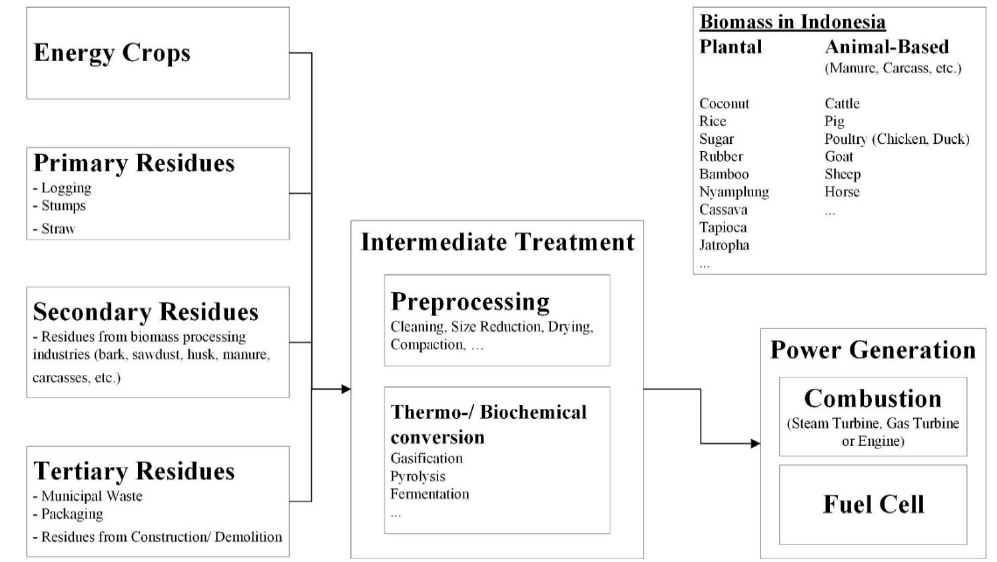
Figure 4. Biomass in Indonesia and options for power production (based on [44–49]).